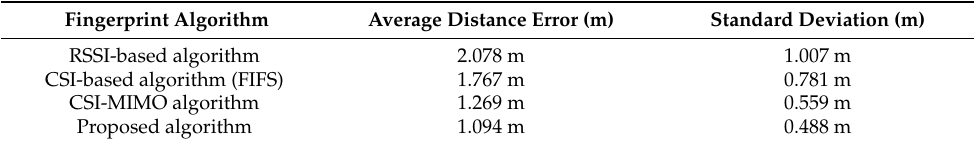
Table 4. Comparison of indoor fingerprint location algorithms (lobby of IT-2